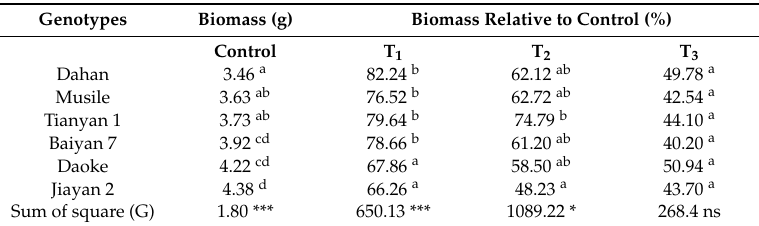
Table 2. Comparison of shoot biomass of six oat genotypes under control conditions and biomass relative to control. Values shown for control conditions (g) and di ff erent levels of salinity (%) are the means of three replicates. Means followed by di ff erent letters are significantly di ff erent ( p < 0.05) according to Tukey’s-b test. The associated sum of squares and probabilities (ns, not significant; * p < 0.05 and *** p < 0.001) are shown.